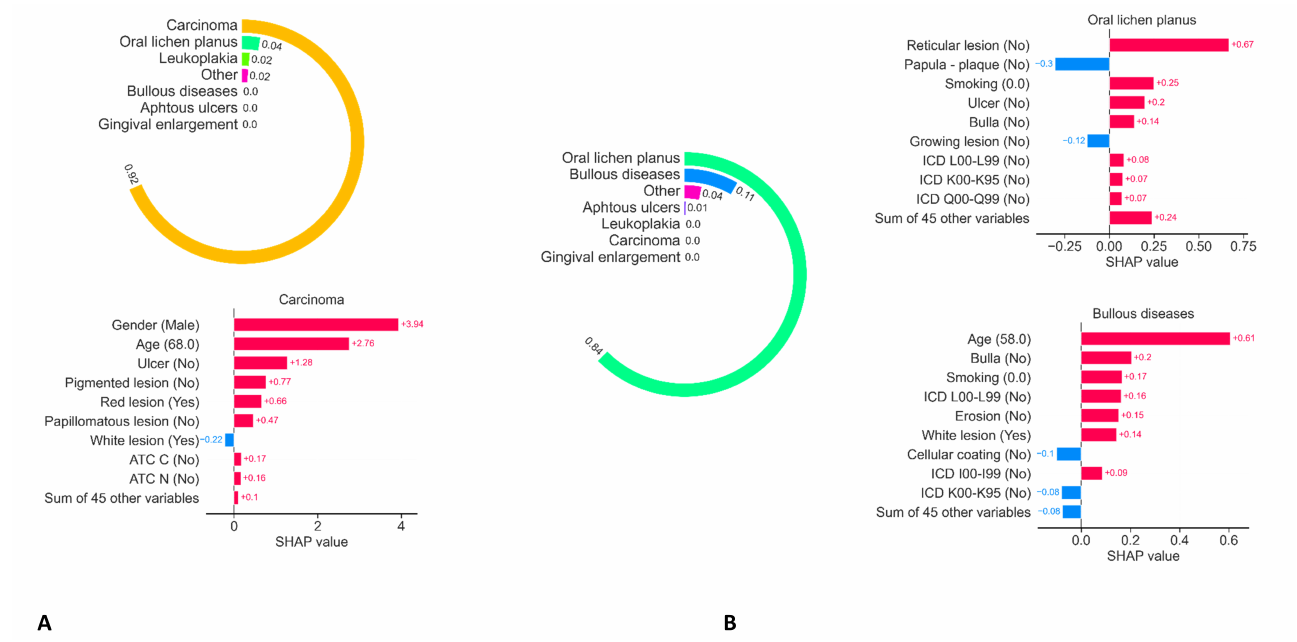
Figure 3. Illustration of two examples of prediction, respectively for a carcinoma ( A ) and an oral lichen planus lesion ( B ). The SHAP algorithm provides an understanding of decision making by outlining the factors that positively or negatively influence the different diagnoses.